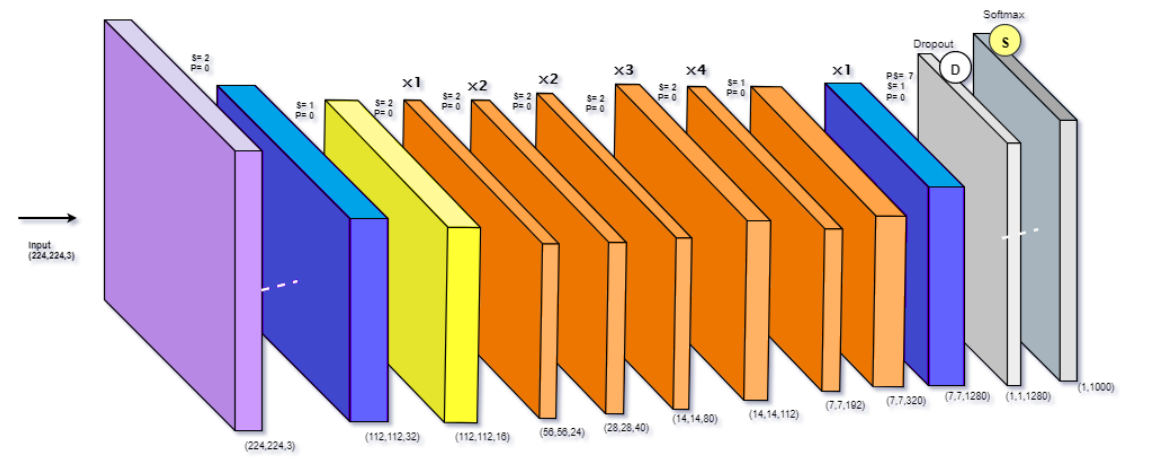
Figure 15. EfficientNet